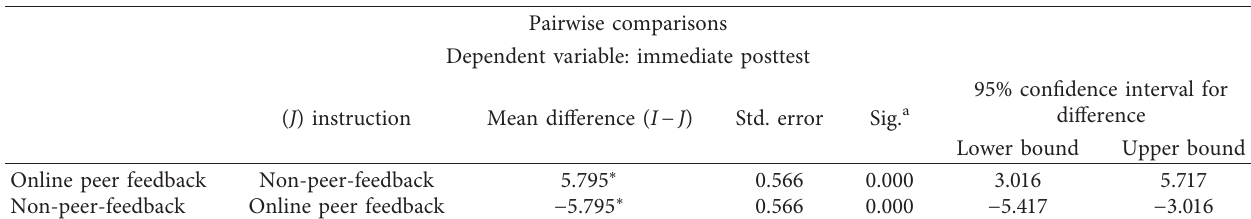
Table 6: Pairwise comparisons of online peer feedback and non-peer-feedback groups on the